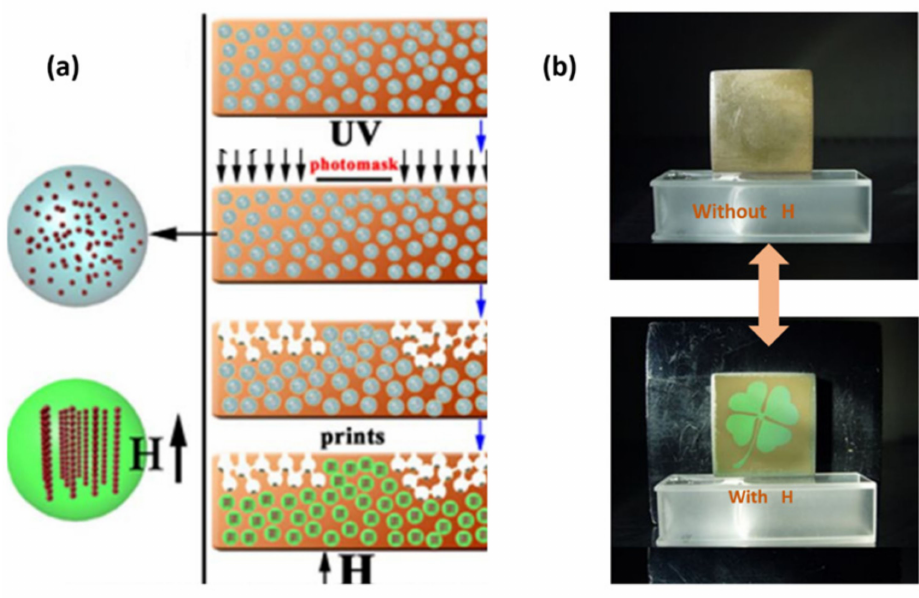
Figure 10. Invisible print shown by a magnetic field was fabricated by selective immobilization. ( a ) Schematic illustration of the preparation process of the invisible colloidal PC pattern shown by magnetic field. ( b ) The pattern was invisible in the absence of a magnetic field but visible when applying a magnetic field. Reused with permission from Reference [50], Copyright 2012, Springer